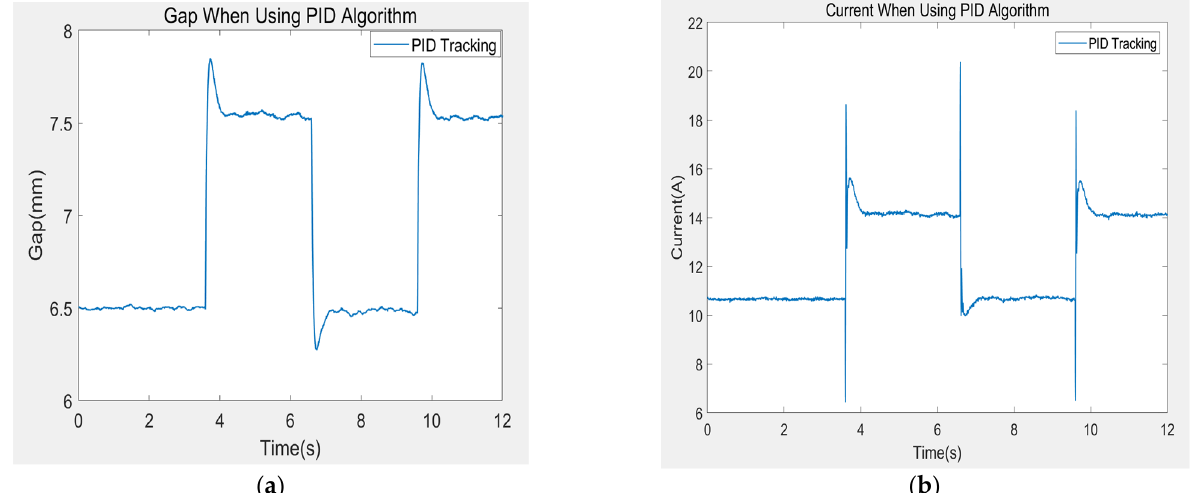
Figure 20. Gap and current value under PID control algorithm: ( a ) Gap value; ( b ) current value.